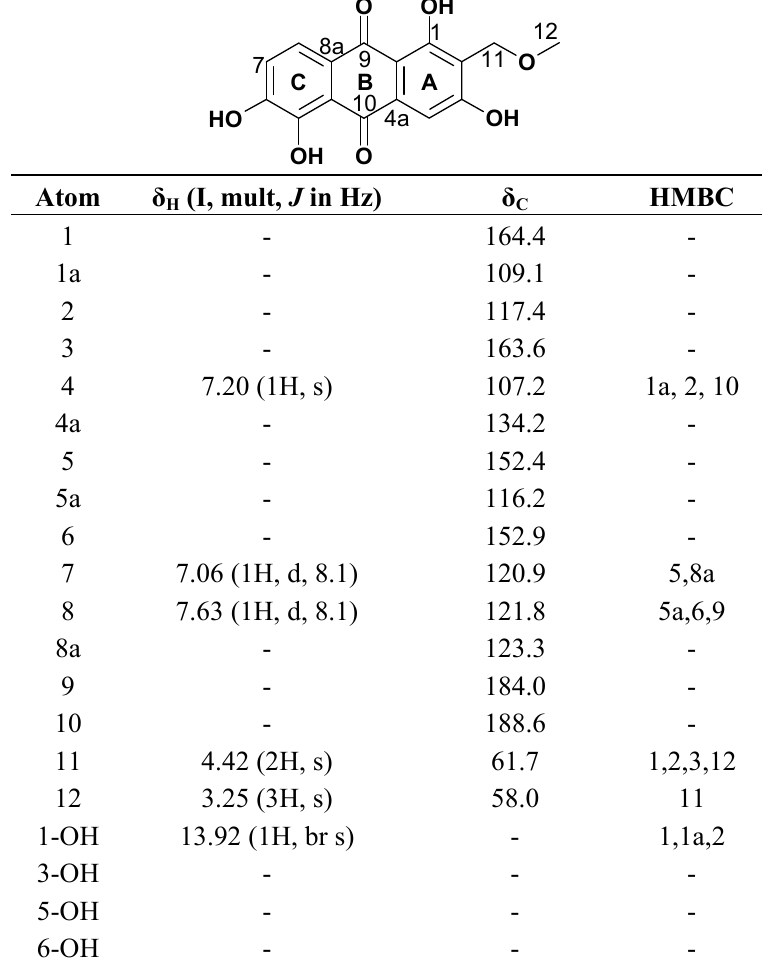
Table 1. The 1 H and 13 C-NMR data for 5,6-dihydroxylucidin-11- O -methyl ether ( 6 ) in DMSO- d